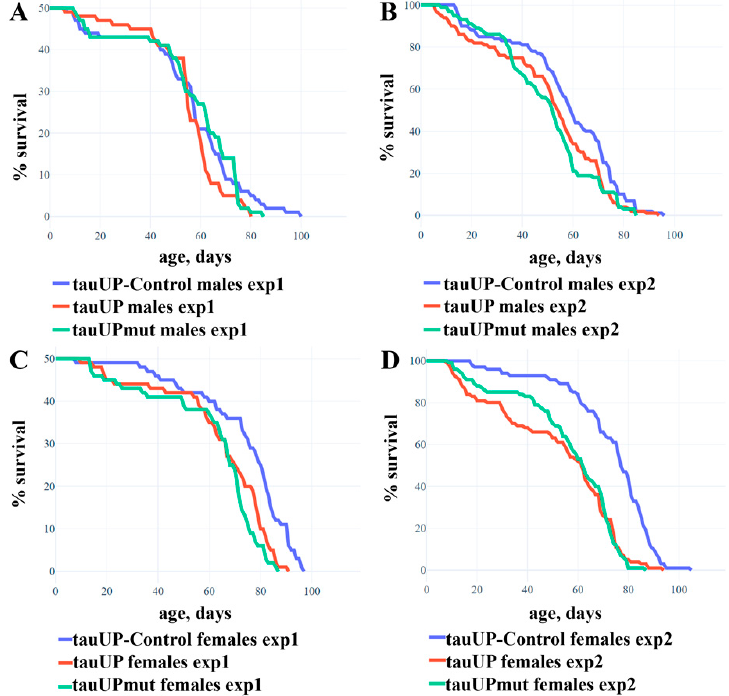
Figure 1. Increased expression of the normal and mutant RA transcript of the tau gene leads to a significant decrease in the lifespan of females and a minimal or insignificant effect on the lifespan of males. ( A , B )—Experiments 1 and 2 with males. ( C , D )—Experiments 1 and 2 with females. A detailed description of the genotypes is given in the Materials and Methods section. Statistical analysis of the data is given in Supplementary Table